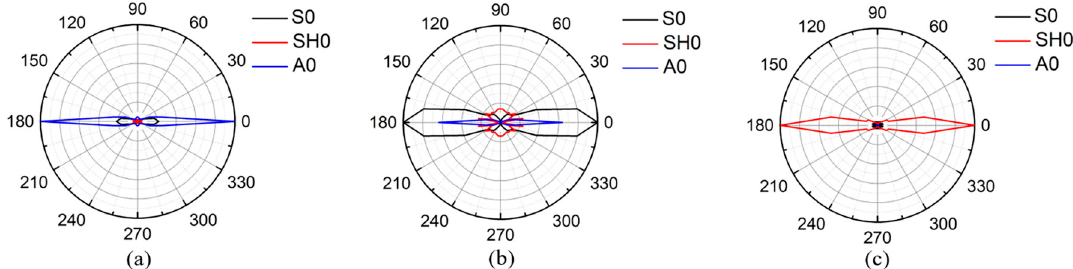
Figure 3. Directivity of guide waves excited by different types of line sources on plates: ( a ) Normal loading; ( b ) Tangential shear loading; ( c ) Anti-plane shear loading.